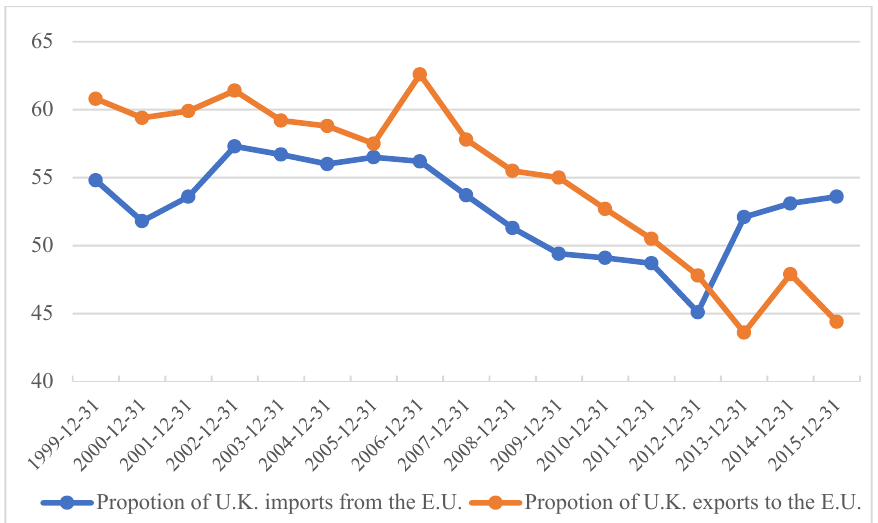
Propotion of U.K. imports from the E.U. Propotion of U.K. exports to the E.U. Figure 1. Trade between the United Kingdom and the European Union during 1999-2015. Data source: (Available online: http://www.hibor.com.cn, accessed on 15 June 2021).